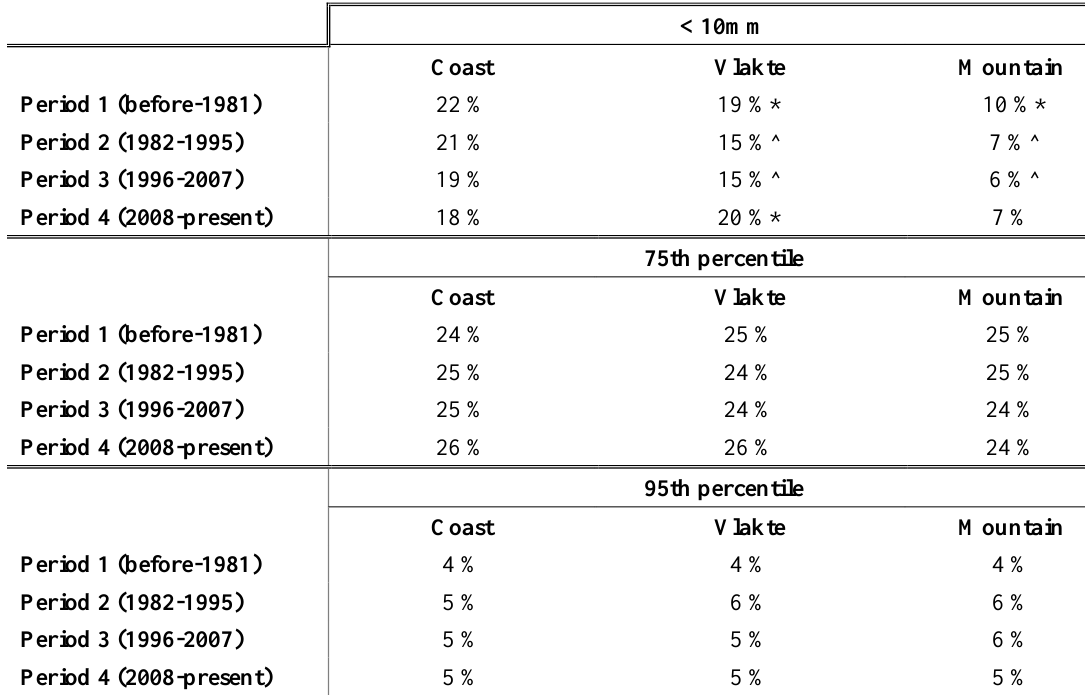
Table A3.5: Monthly rainfall according to three ‘extreme’ categories (less than 10mm; 75th percentile; 95th percentile) divided up into areas. Where significant, the t-test statistic was greater than 1.96 (corresponding p-value of less than 0.05) and hence was significant at the 95 percent significance